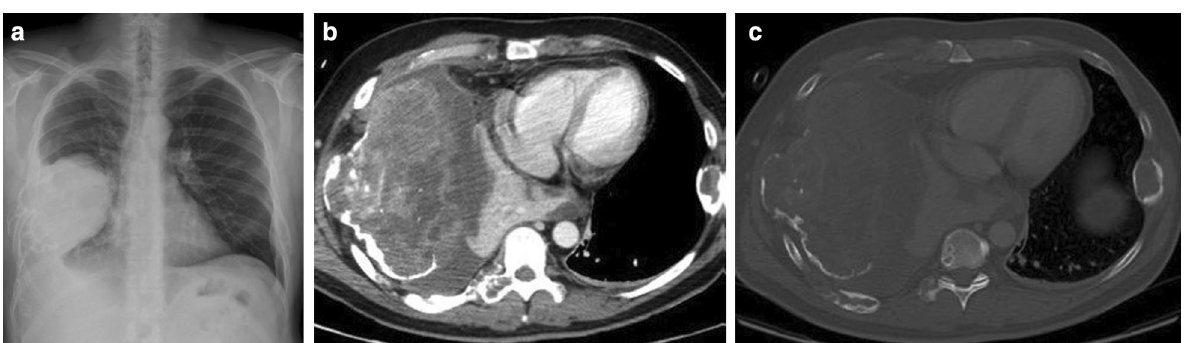
Fig. 11 Diagnosis: osteosarcoma. Technique: standard chest radiography and contrast-enhanced chest CT. Description: A 50-year-old man presented with complaints of right-sided chest pain. The postero-anterior chest radiograph ( a ) shows a large mass located at the lateral side of the right hemithorax with an associated pleural effusion. Note also a lytic expansion of the 8th left rib. The axial contrast-enhanced CT in the mediastinal window setting ( b ) confirms the heterogeneous mass with intralesional necrosis and calcifications originating from the 7th right rib, with focal expansive destruction, best seen in the bone window ( c ). There is a known pleural effusion with adjacent compression atelectasis of the right lower lobe. Histopathologic examination of the large mass confirmed the diagnosis of an osteosarcoma. The expansive tumorlike lytic lesion of the 8th left rib corresponds with fibrous dysplasia